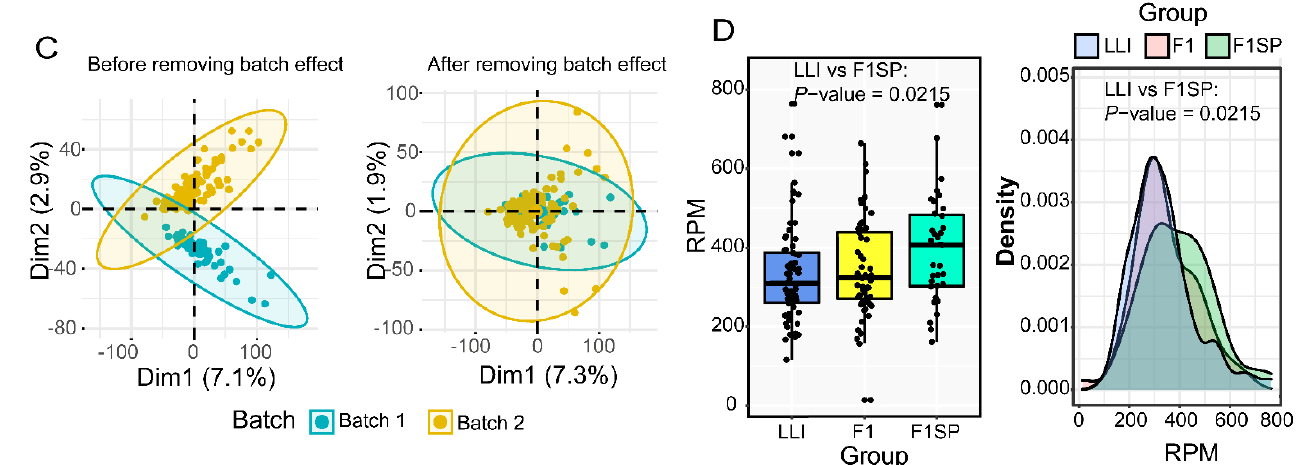
Figure 1. Identification and general expression pattern of circRNAs in longevous families. ( A ) CircRNA identification pipeline used in this study. CIRCexplorer pipeline [17] was used for rRNA- depleted RNA-seq data. In total, 17,081 high-quality circRNA transcripts were identified for next-step analysis. ( B ) Comparison between annotated circRNAs acquired from three databases (circBase [33], circbank [32] and CIRCpedia [34]) and circRNAs identified in this study. ( C ) The PCA plot was used to estimate batch effect of samples. ( left panel : distribution of samples before removing batch effect; right panel : distribution of samples after removing batch effect). ( D ) CircRNA expression levels in LLI, F1SP-F and F1 groups ( left panel : RPM distribution; right panel : kernel density histogram).